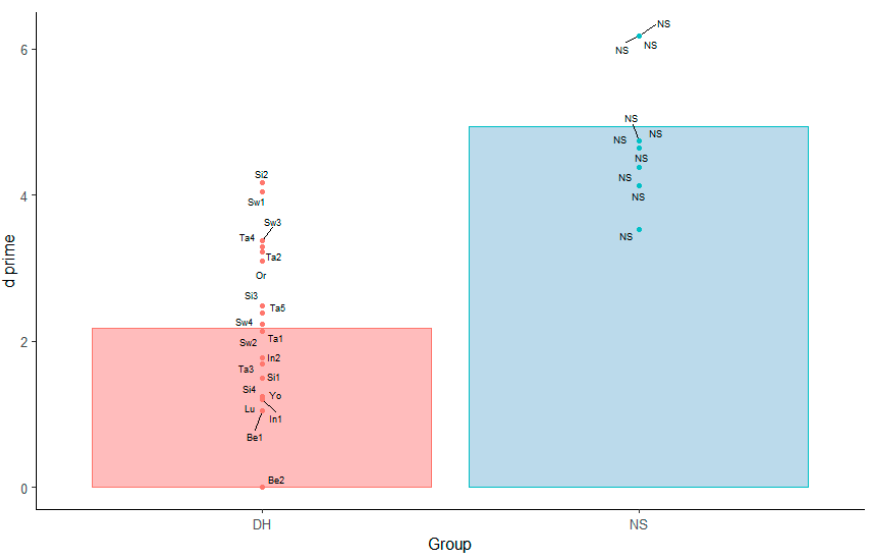
Figure 1. Mean d prime scores of the foreign domestic helper listeners (DH) and the native speaker (NS) control group. (NS) control